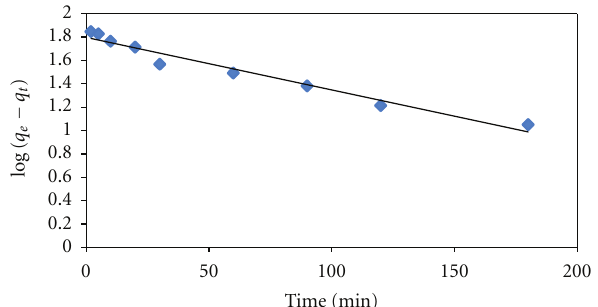
F8:LagergrenplotforadsorptionofAO-7onANPat100ppm dye concentration, 303K, pH = 5.